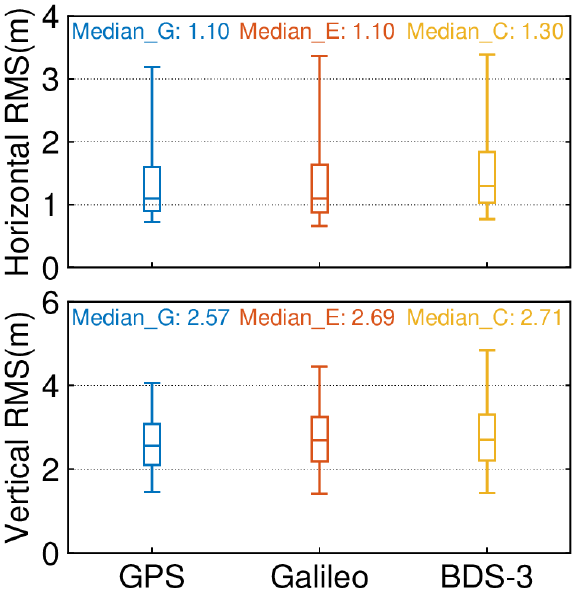
Figure 6. Number of visible satellites and PDOP values for the two tracking stations, BRMG and ABPO.